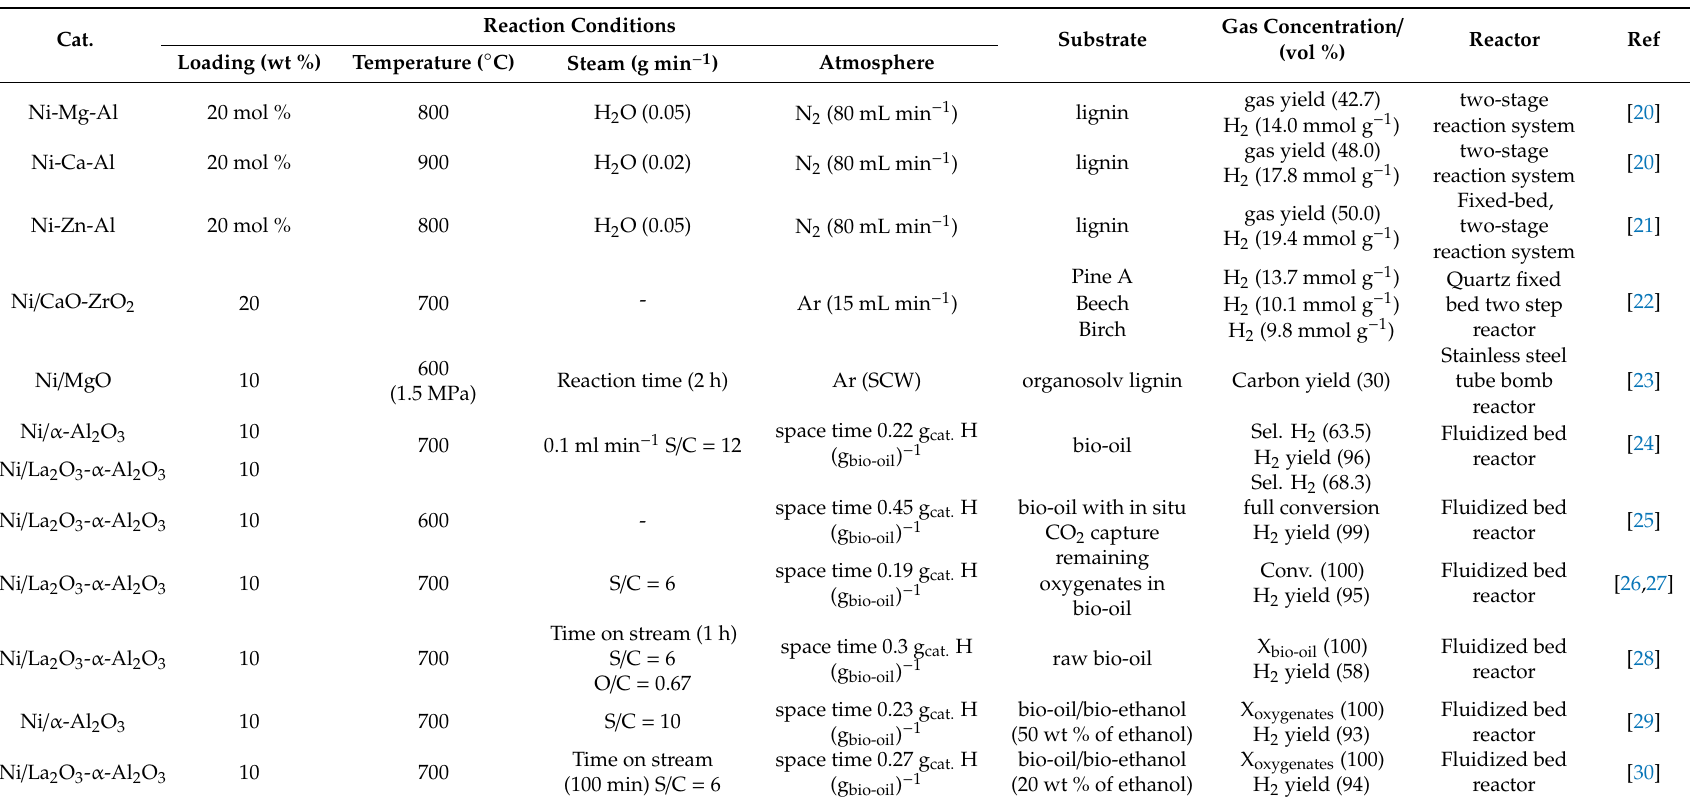
Table 2. Pyrolysis of lignin to gas over Ni-based